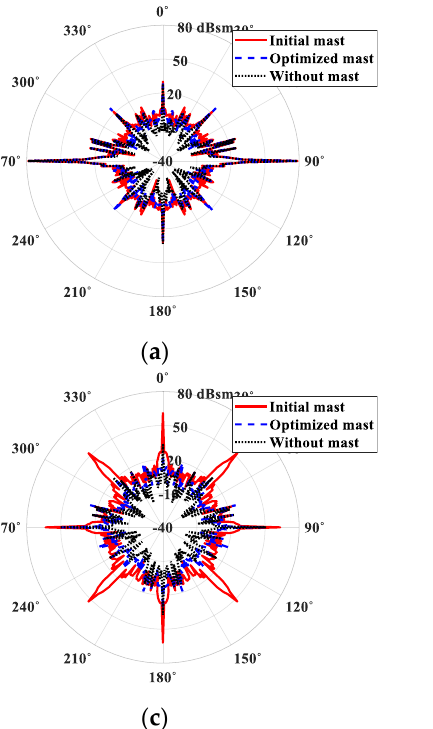
Figure 10. RCS pattern of a naval vessel equipped with the integrated mast in the azimuth plane in the L-band. ( a ) HH polarization at an elevation angle of 0°, ( b ) VV polarization at an elevation angle of 0°, ( c ) HH polarization at an elevation angle of 10°, ( d ) VV polarization at an elevation angle of 10°.